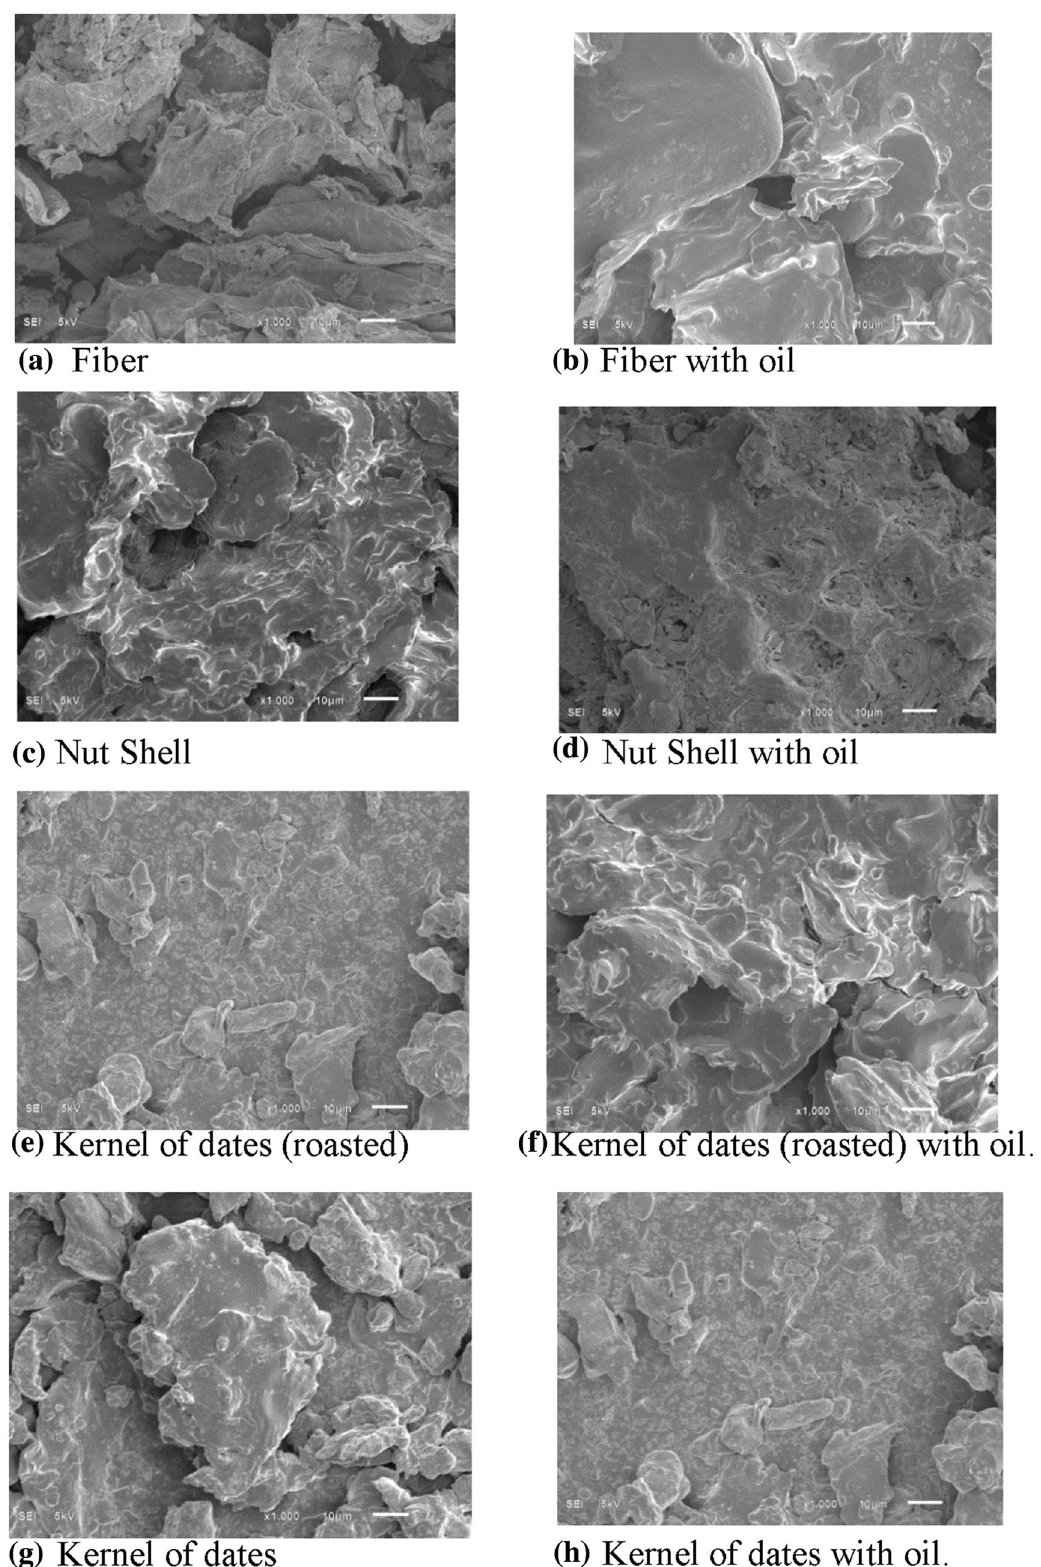
Fig. 16 SEM images × 1000 magnification of bio materials with and without